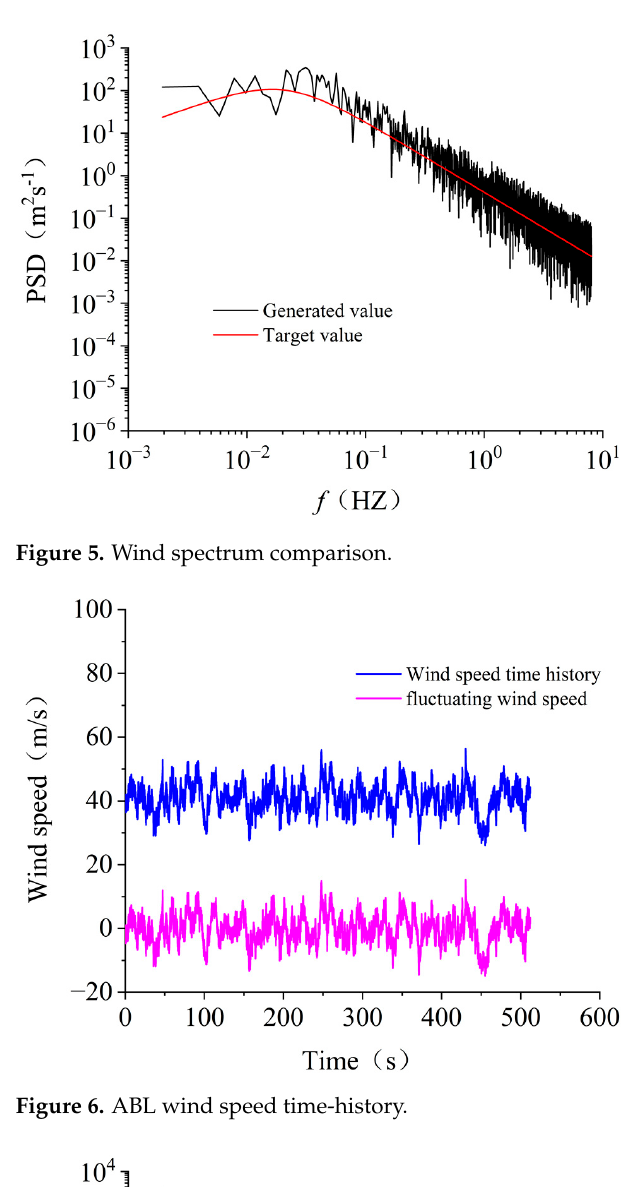
Figure 4. Downburst wind speed time history.